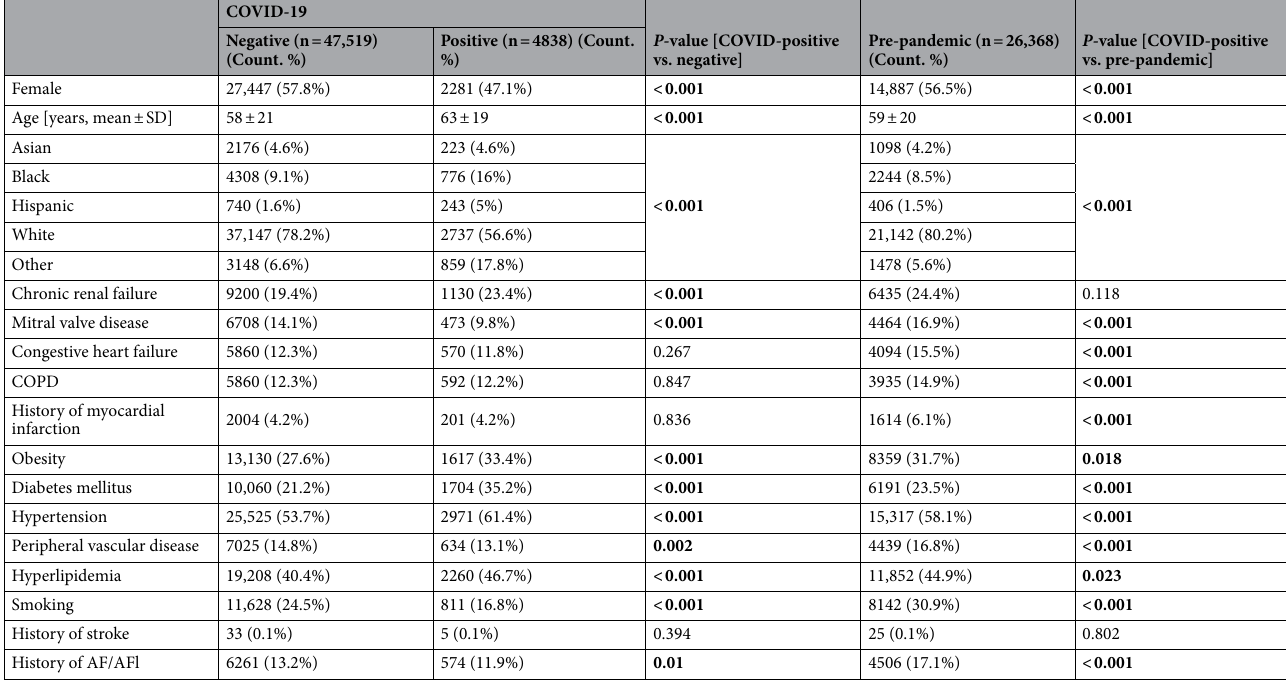
Table 1. Unmatched patient characteristics. AF atrial fibrillation, AFl atrial flutter, COPD Chronic obstructive pulmonary disease. Significant values are in [bold].